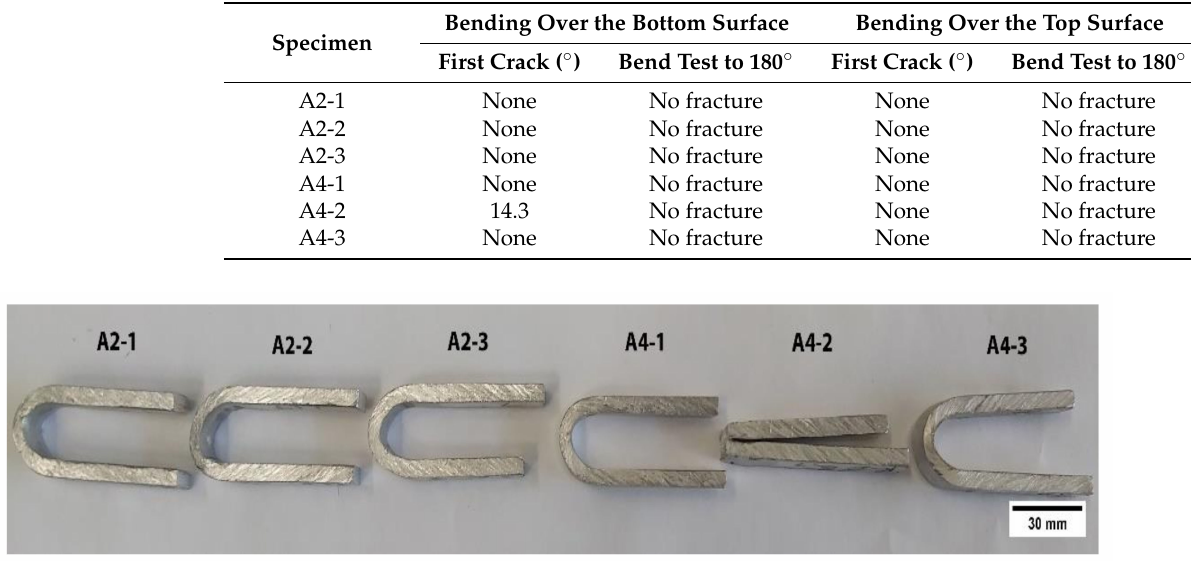
Figure 10. Bend testing specimens over the bottom of the